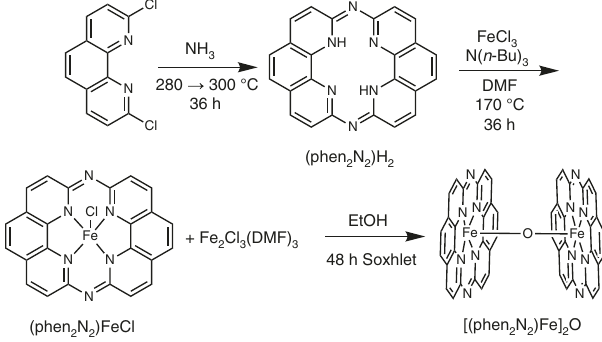
Fig. 2 Syntheses of (phen 2 N 2 )H 2 , (phen 2 N 2 )FeCl, and [(phen 2 N 2 )Fe] 2 O. The (phen 2 N 2 )H 2 macrocycle was synthesized by the reaction of 2,9- dichloro-1,10-phenanthroline with anhydrous ammonia. The (phen 2 N 2 )FeCl model complex was obtained by treatment of (phen 2 N 2 )H 2 with FeCl 3 in the presence of N( n -Bu) 3 under an inert atmosphere. Continuously washing (phen 2 N 2 )FeCl with hot ethanol for 48 hours using a Soxhlet apparatus yielded the [(phen 2 N 2 )Fe] 2 O model